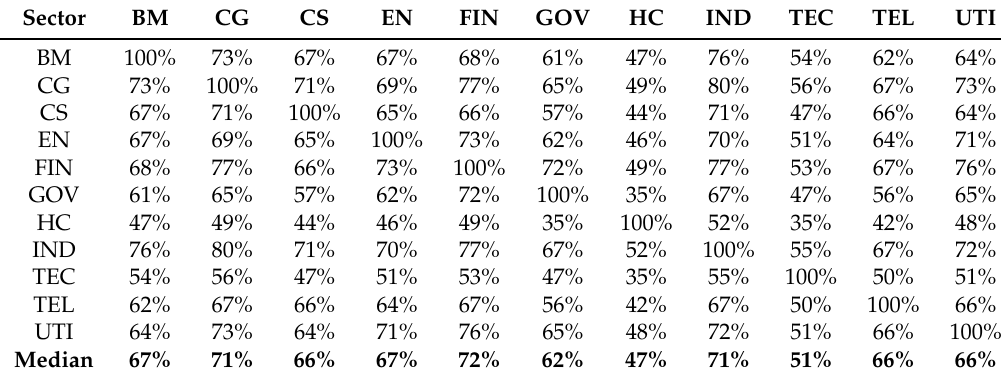
Table 4. Sectorial correlation